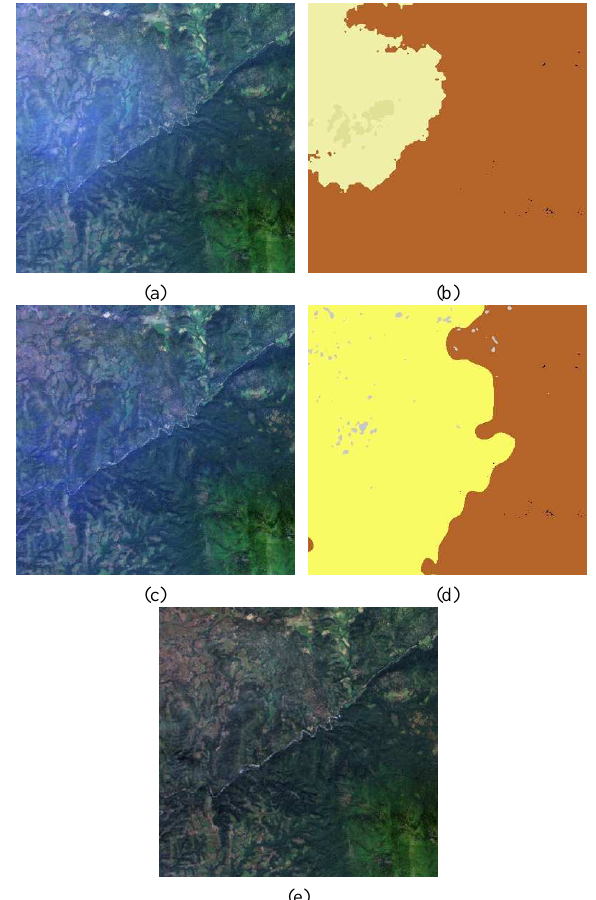
Figure 4: Cirrus removal in the Sentinel-2 data (subscene): a) the original (RGB composite), b) the 1.38 µ m based decirrus map, c) the 1.38 µ m based decirrus, d) the CTM cirrus map, e) the CTM decirrus.